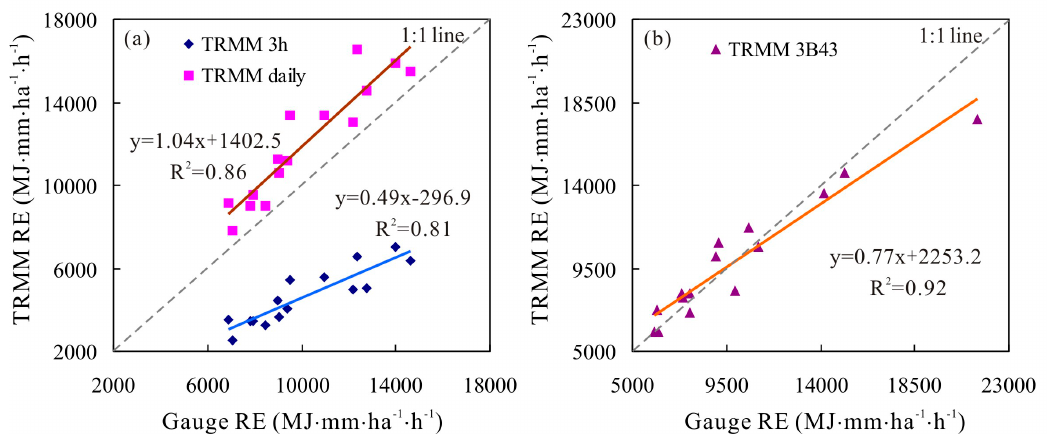
Figure 7. Scatter plots of annual rainfall erosivity from ( a ) TRMM 3h and daily products and ( b ) TRMM 3B43.